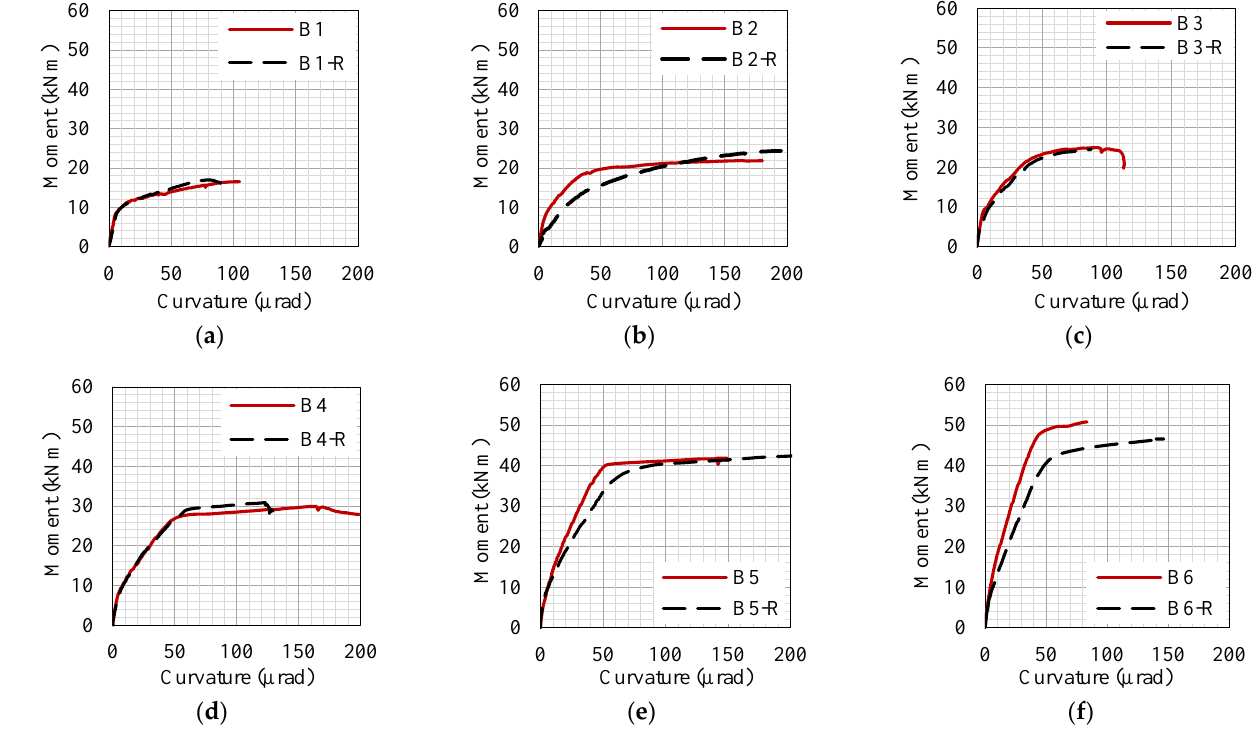
Figure 9. Moment – curvature responses of ( a ) B1, ( b ) B2, ( c ) B3, ( d ) B4, ( e ) B5, and ( f ) B6. Figure 10a depicts a representative moment–curvature response for B1–B6. This figure demonstrated that all bar-reinforced beams, except B6, were likely under-reinforced (tension-controlled). Additionally, the slope of the pre- and post-steel yielding was almost typical for all beams. This was due to the efficient hybrid fibrous system in the UHPC that controls the post-cracking curvatures of beams. The relation between the moment capacity and bar reinforcement ratio is presented in Figure 10b. This figure shows the robust linearity of this relation (with a 99% correlation